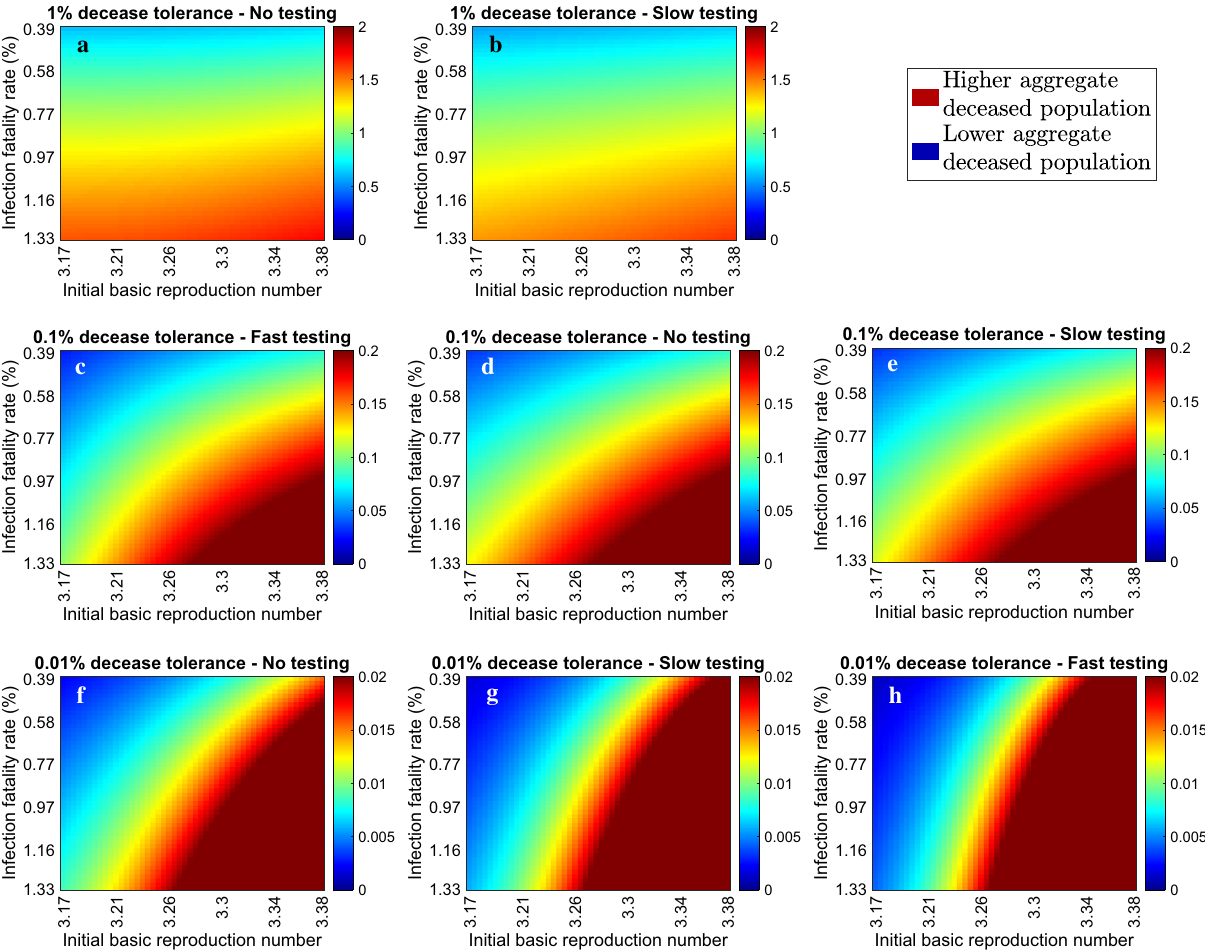
Figure 5. Effect of uncertainty in the initial reproduction and infection fatality rates on the aggregate deceased population. Portion of aggregate deceased population for ¯ R 0 ∈ [ 3.17, 3.38 ] and infection fatality rate ranging between 0.39 and 1.33% associated with decease tolerances of 1% ( a,b ), 0.1% ( c–e ) and 0.01% ( f–h ) when no ( a,c,f ), slow ( b,d,g ), and fast ( e,h ) testing policies are implemented. Fast testing always limits the deceases to less than 1% and hence there is no corresponding case. The values were acquired by applying in each case the optimal continuous government intervention strategy obtained with ¯ R 0 = 3.27 and infection fatality rate of 0.66%. Dark red and dark blue colours correspond to aggregate deceases that are at least twice the adopted tolerance levels and zero respectively. Additional results that demonstrate the impact of parametric uncertainty in forming effective government mitigation strategies are provided in the SI (Supplementary Figs.